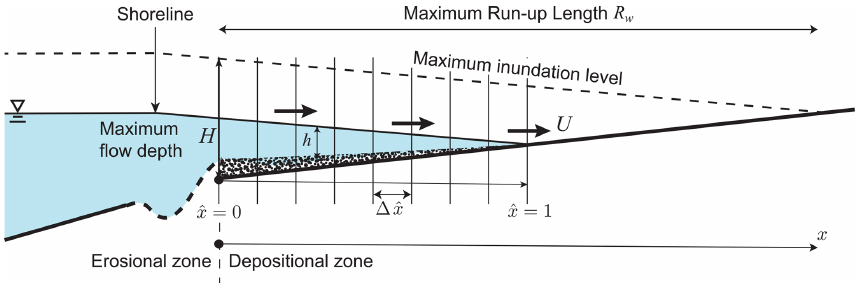
Figure 5. Explanation of model domain configuration. The assumption of velocity of tsunami run-up U is constant in time and space. The inundation depth h increases constantly until it reaches its maximum value H at the seaward boundary. R w is the maximum inundation distance. The bed-attached streamwise coordinate x is set transverse to the shoreline and is positive landward. Within the applied transformed coordinate system, the moving front edge of the tsunami is located at a fixed value of the dimensionless spatial coordinate ˆ x = 1 (modified from Naruse and Abe,